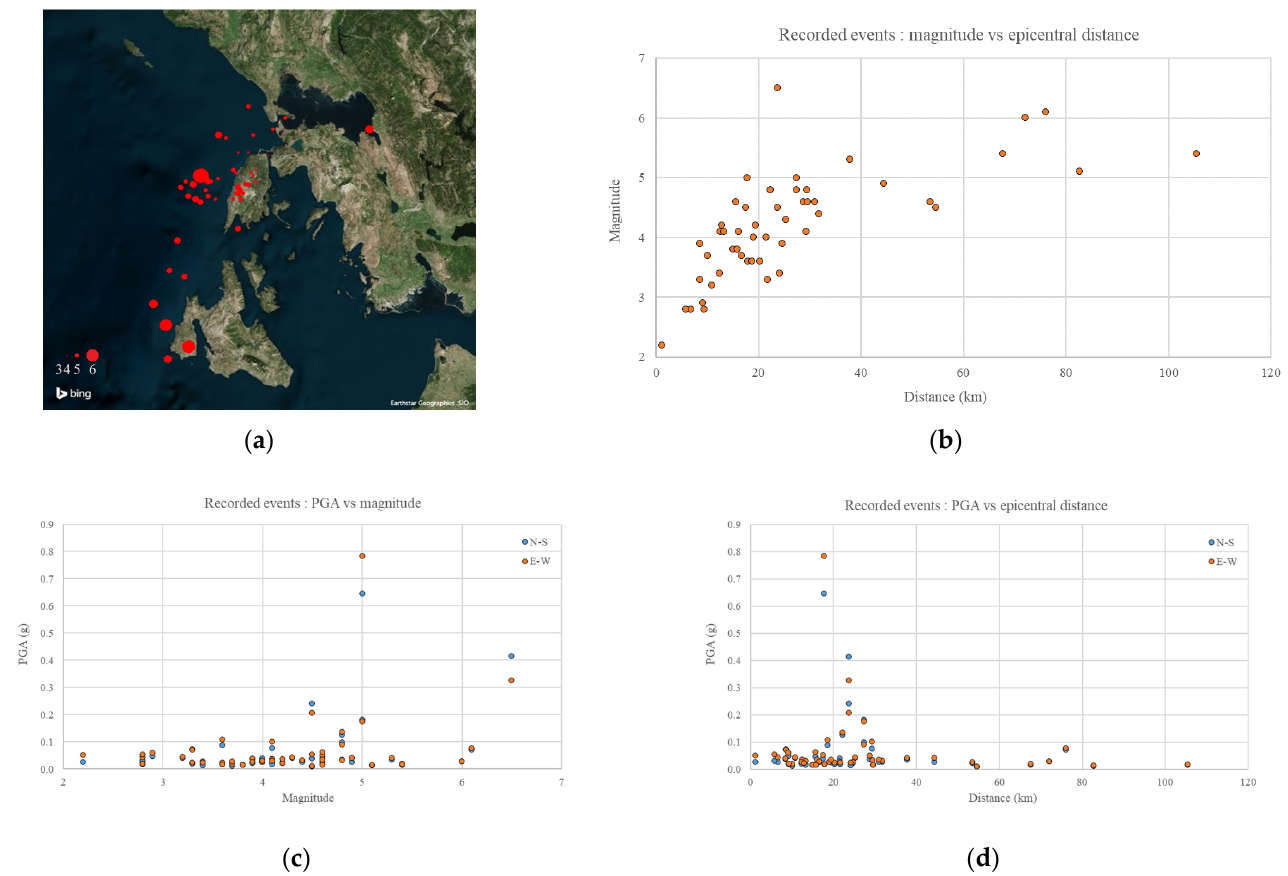
Figure 8. Recorded earthquakes ( a ) epicenters, ( b ) magnitude vs. distance, ( c ) PGA vs. magnitude, ( d ) PGA vs. distance.